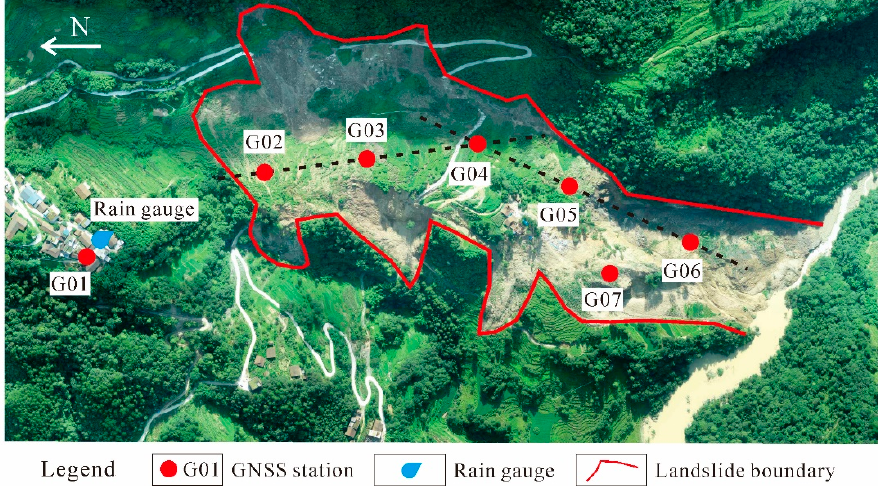
Figure 9. GNSS monitoring system on the Zhongbao landslide.